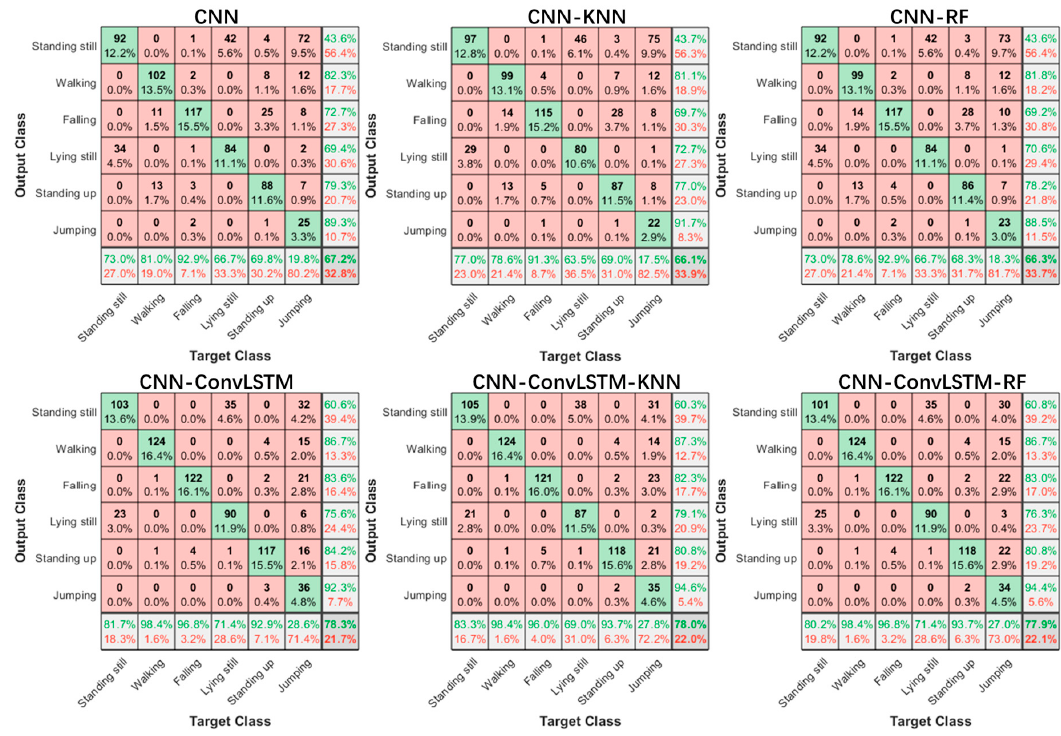
Figure 9. Confusion matrices of six activities where the model was used to classify the samples collected in the heavily furnished lounge.